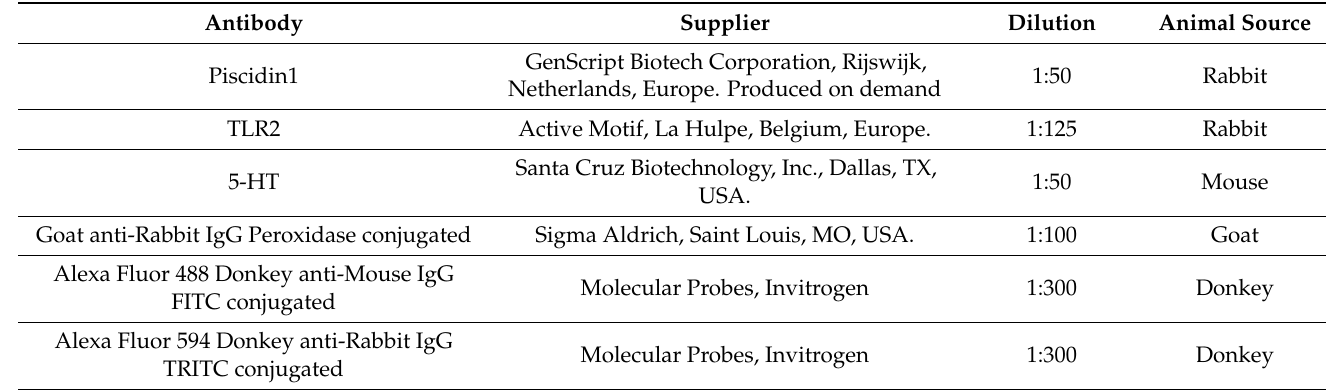
Table 2. Antibodies